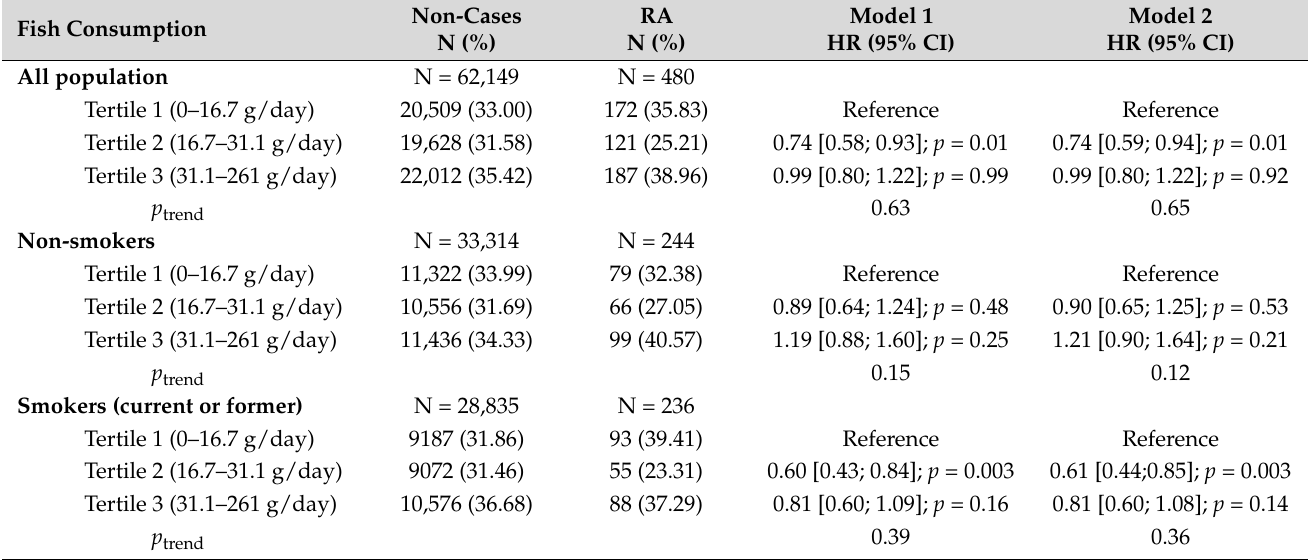
Table 2. Hazard ratios (95% confidence intervals) for the risk of rheumatoid arthritis (RA) by tertiles of fish consumption (N =